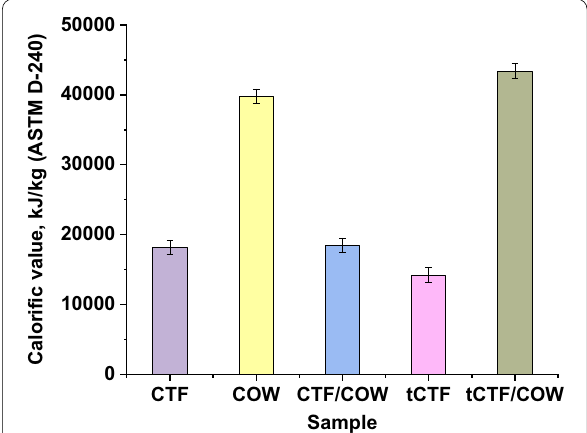
Fig. 4 Calorific value of each substrate before and after fungal enzyme